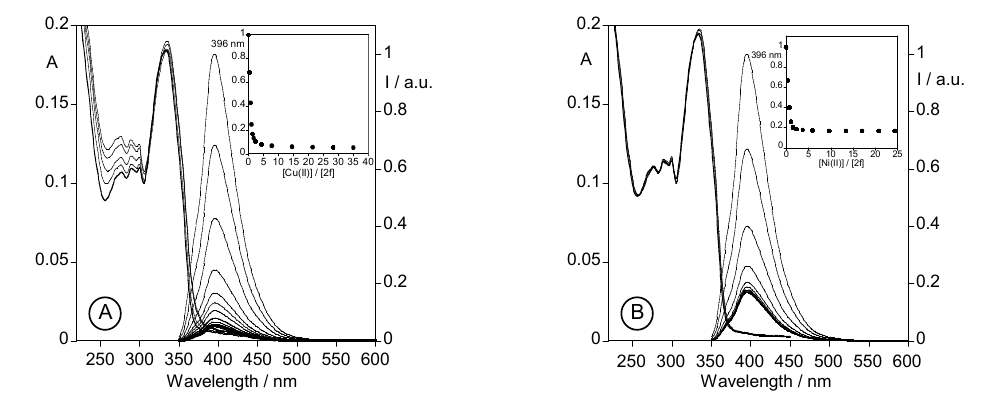
SO ) in absolute ethanol. ([ 2f ] = 1.00E-5 M, T = 298 K, λ 3 2 2 nm. Inset: normalized emission at 395 nm).